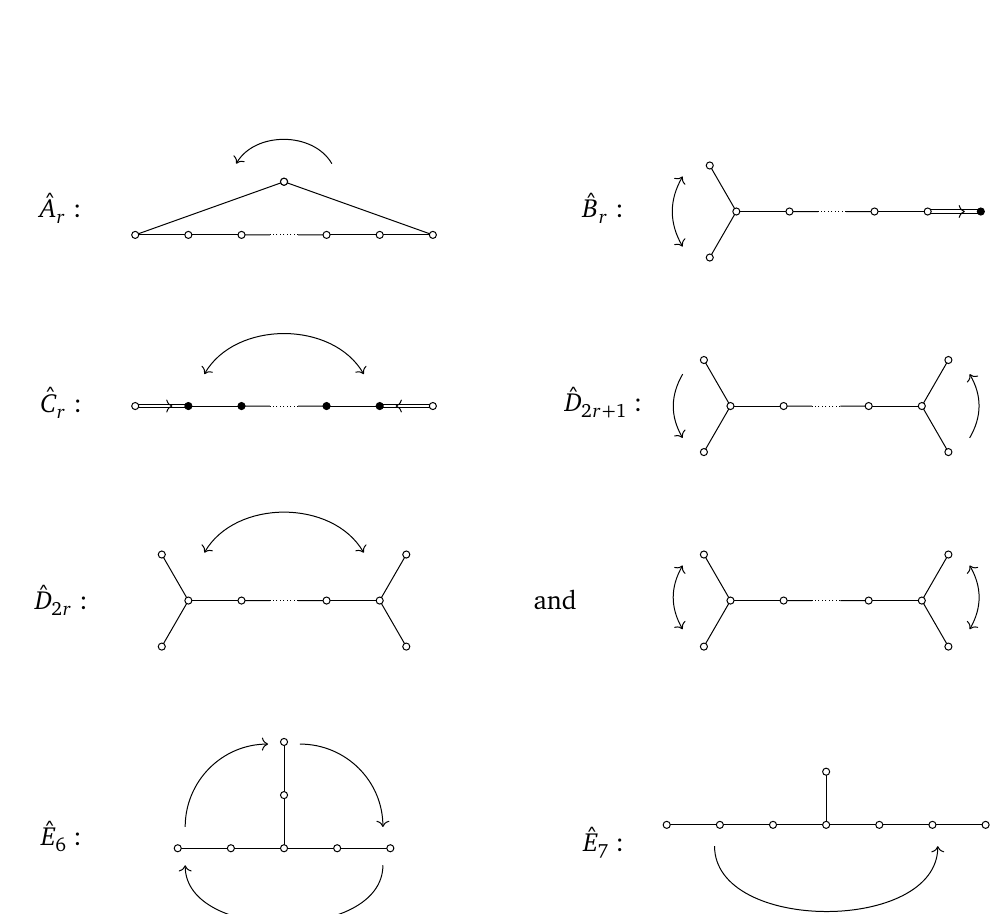
Figure 1: Affine Dynkin diagrams and their outer automorphism are presented. The white node and black node denote long root and short root